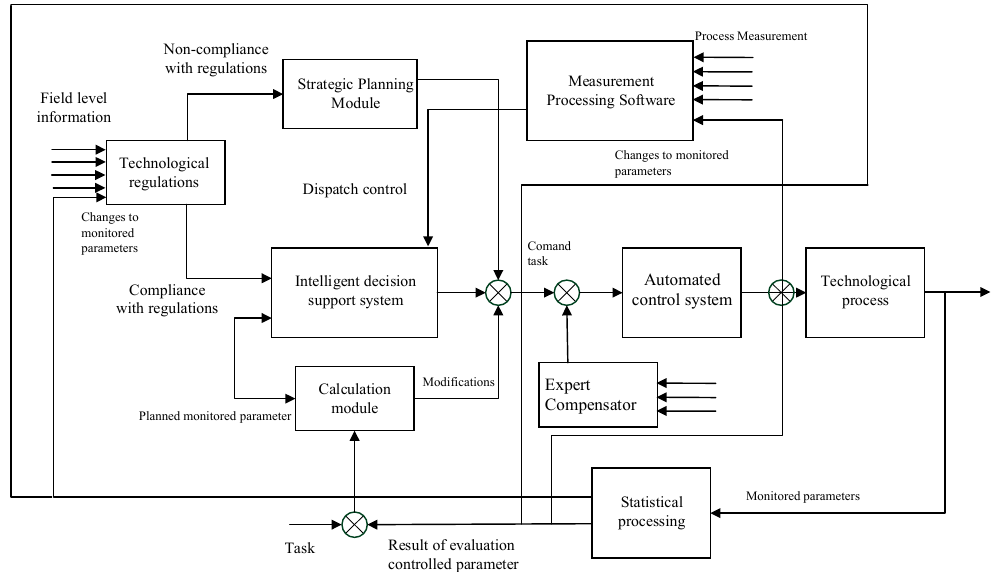
Figure 1. General block diagram of an intelligent automation system for an agricultural enterprise.